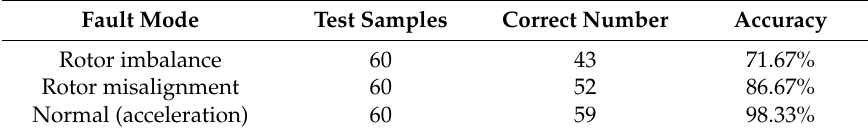
Table 8. Diagnosis results of the gas turbine rotor testbed using the same